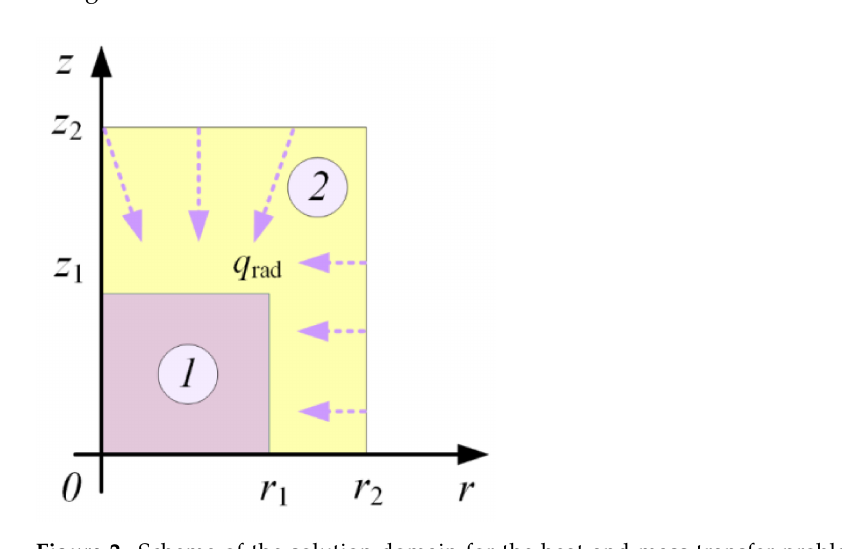
Figure 2. Scheme of the solution domain for the heat and mass transfer problem under radiant heating: 1—gel fuel sample;